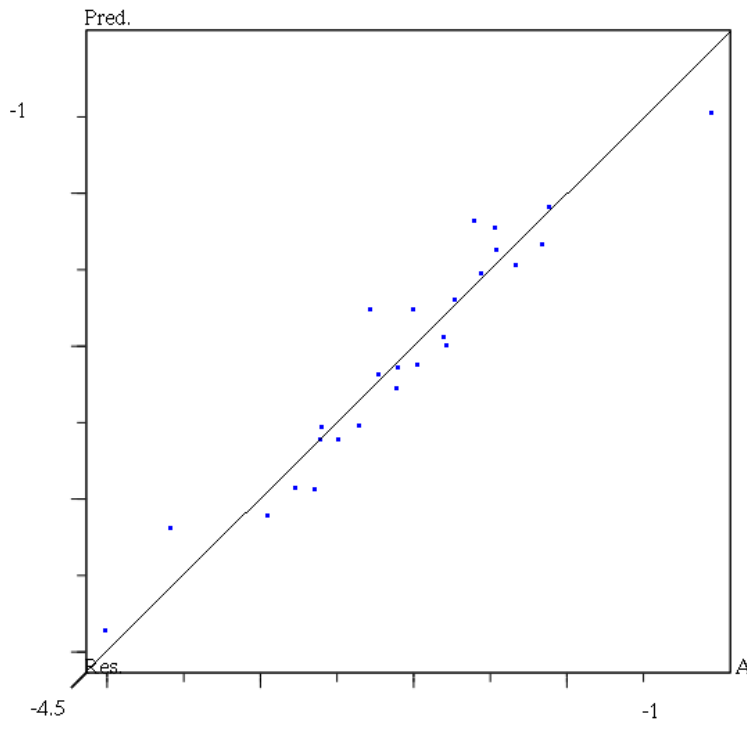
Figure 3. CoMFA predicted as experimental p IC